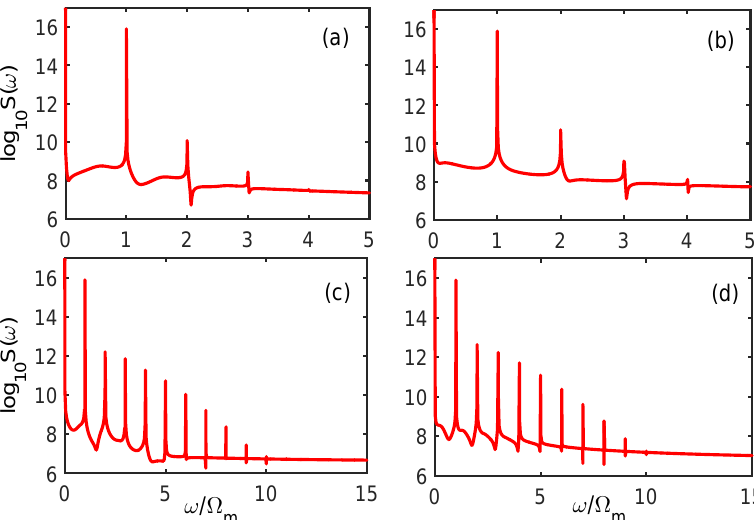
Figure 2. The high-order sideband spectra output from the optomechanical system in the absence of two-level atoms, shown with various charge numbers n : ( a ) n = 50; ( b ) n = 100; ( c ) n = 150; and ( d ) n = 200. The parameters were m = 10 ng, Ω m /2 π = 10 MHz, G /2 π = 0.4 GHz/nm, κ /2 π = 1 MHz, γ m /2 π = 100 Hz, g ac /6 π = 4.2 MHz, γ a /2 π = 2.875 MHz, and r = 67 µ m, K = 8.99 × 10 9 N · m 2 /C 2 , Q 1 = CU with C = 27.5 nF, U = 1 V , ∆ c = ∆ a = Ω m , P l = 0.5